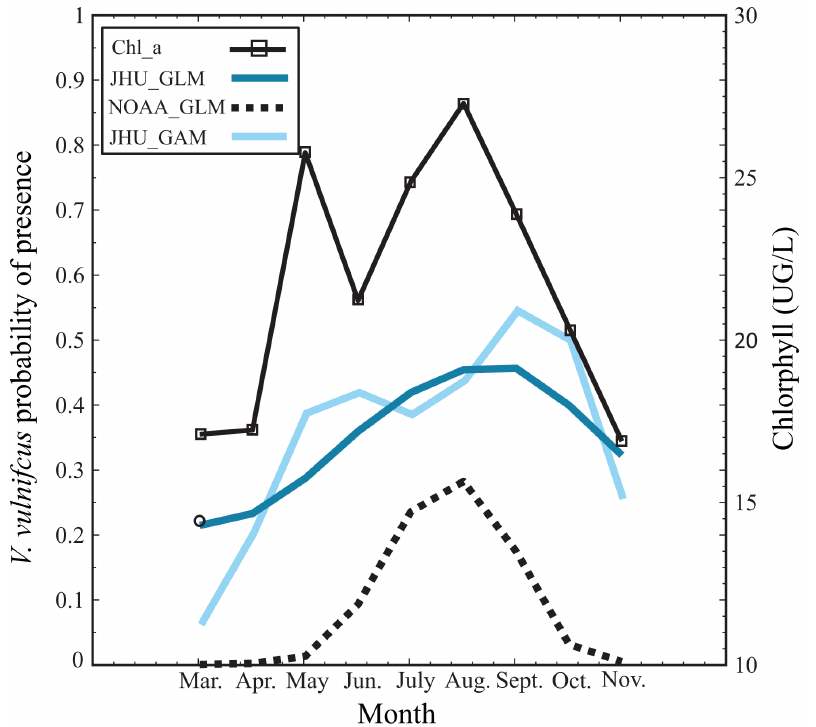
Figure 4. Monthly climatology of Chlorophyll a and V.vulnificus probability for each method averaged over the entire upper Chesapeake Bay.